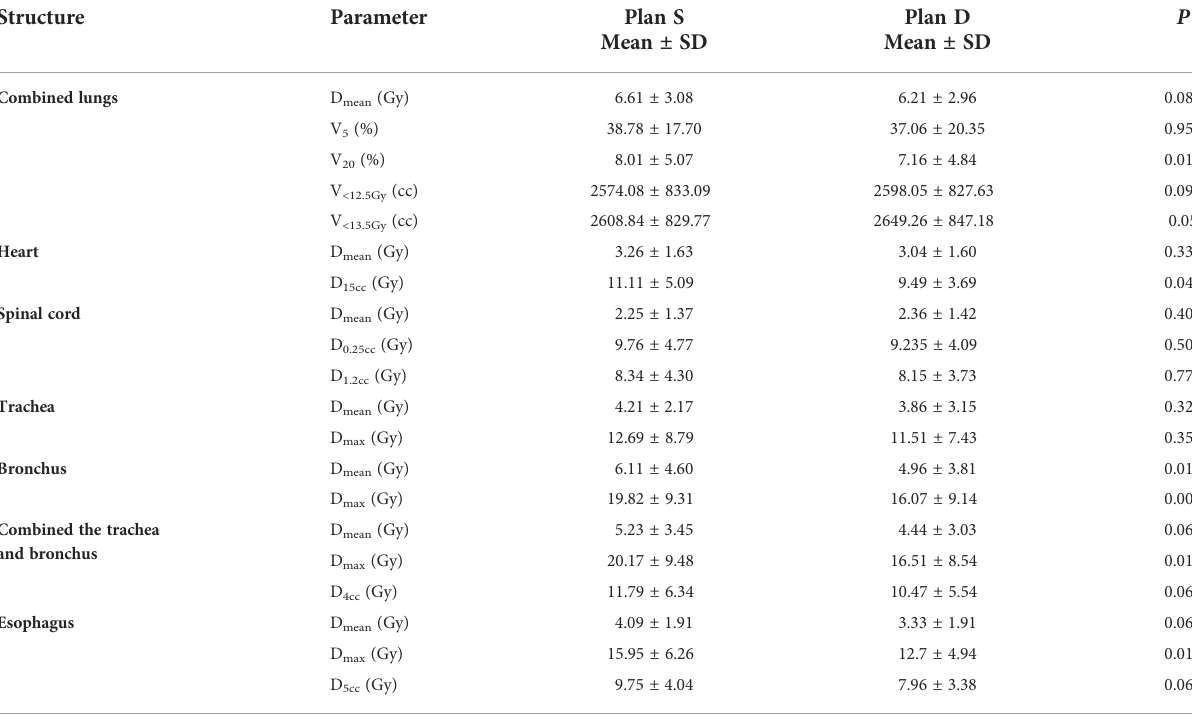
TABLE 4 Dosimetric comparisons of the OARs for Plan S and Plan D.